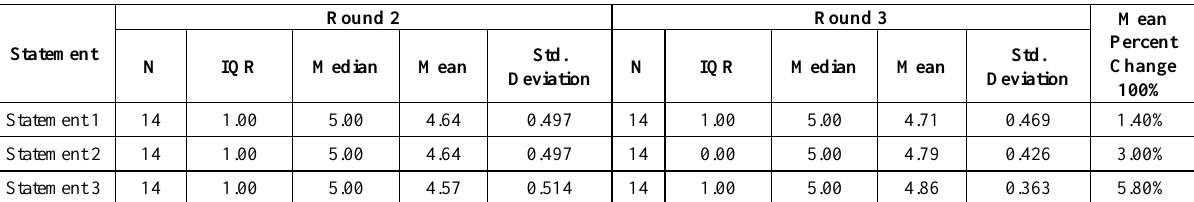
Table 4: Statistical analysis of Round 2 and 3 – NDCDB‘s role in Malaysia